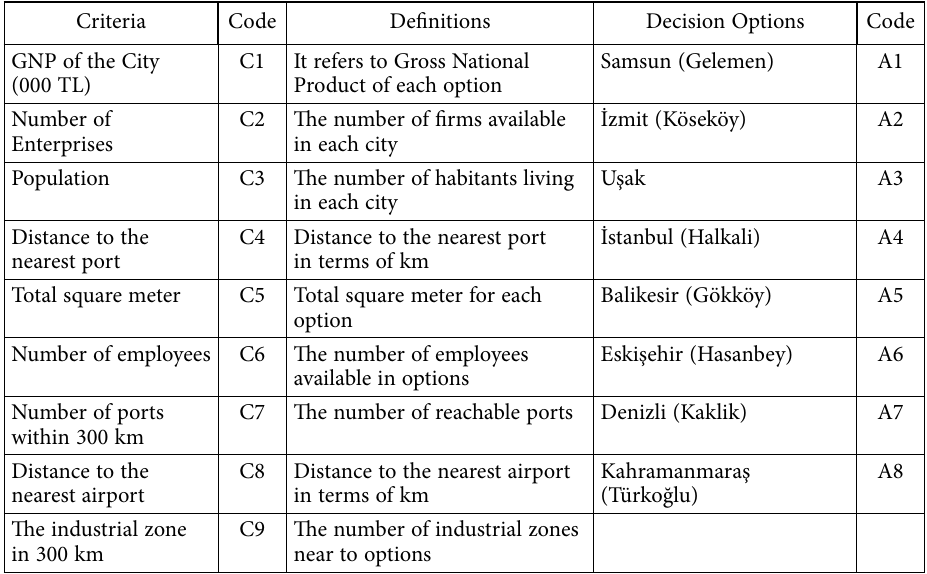
Table 2. The decision alternatives and the selection criteria